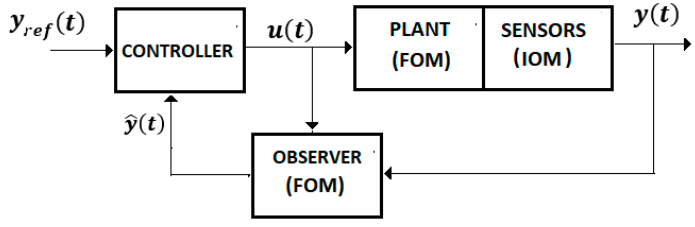
Figure 5. Control system with observer.